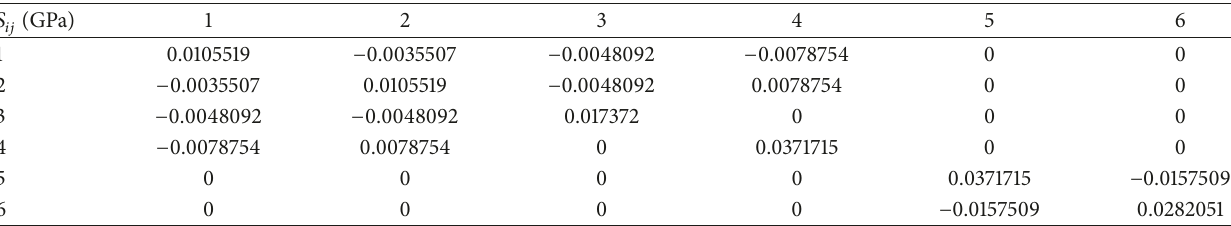
Table 6: Flexible stiffness matrix of calcite crystal.